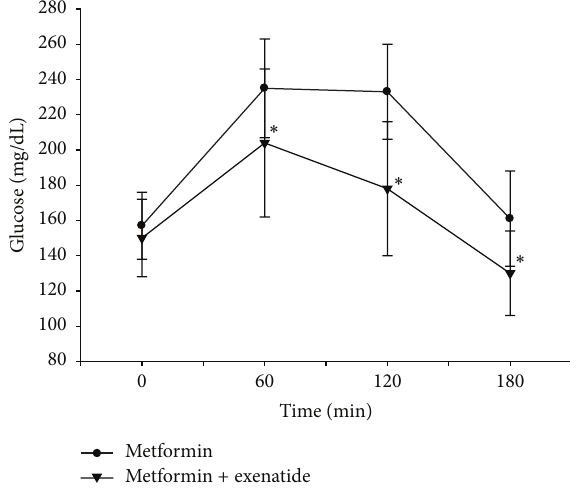
Figure 1: Serum glucose levels following mixed meal test with and without exenatide usage. ∗ 𝑝 < 0.05 when the percentage changes in serum glucose levels of two treatments were compared.